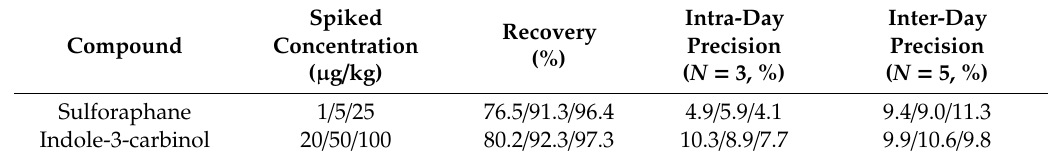
Table 2. Recovery rate, intra-day and inter-day precision for sulforaphane and indole-3-carbinol.